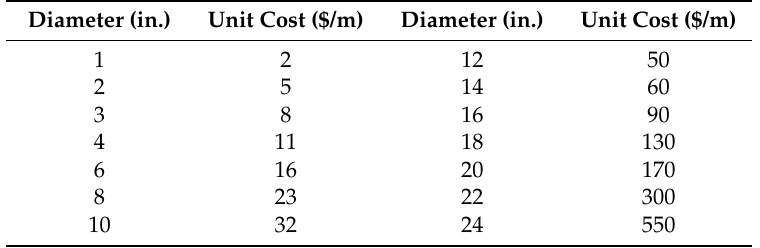
Table 1. Diameter options and associated unit costs of two-loop network (TLN).